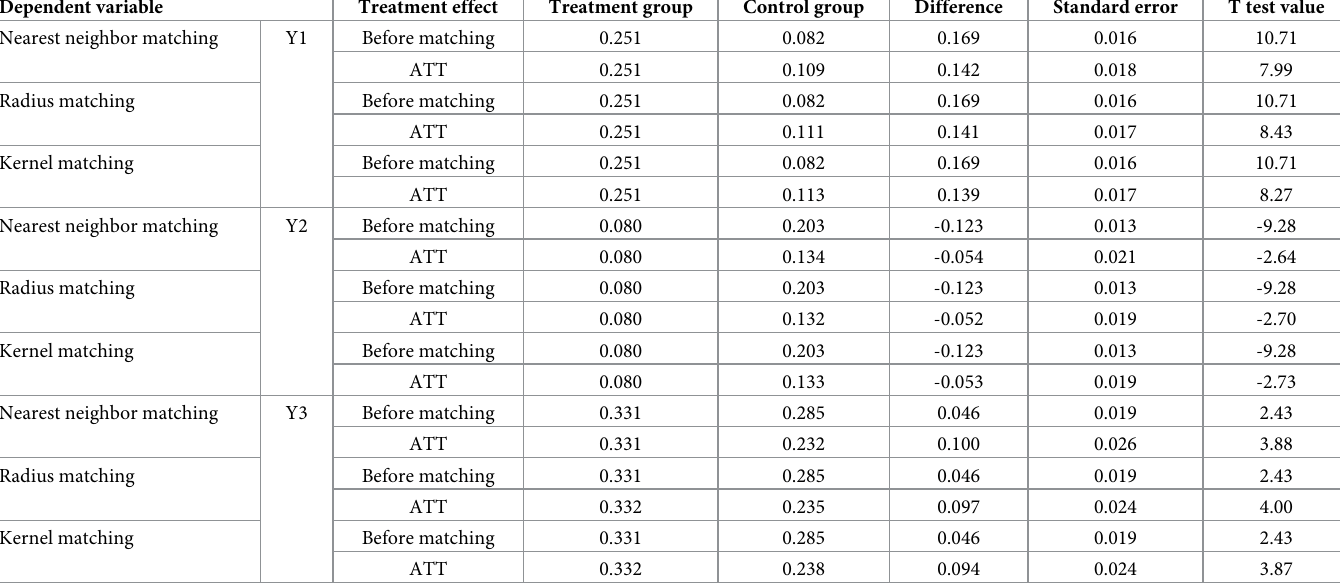
Table 5. Propensity score matching estimation